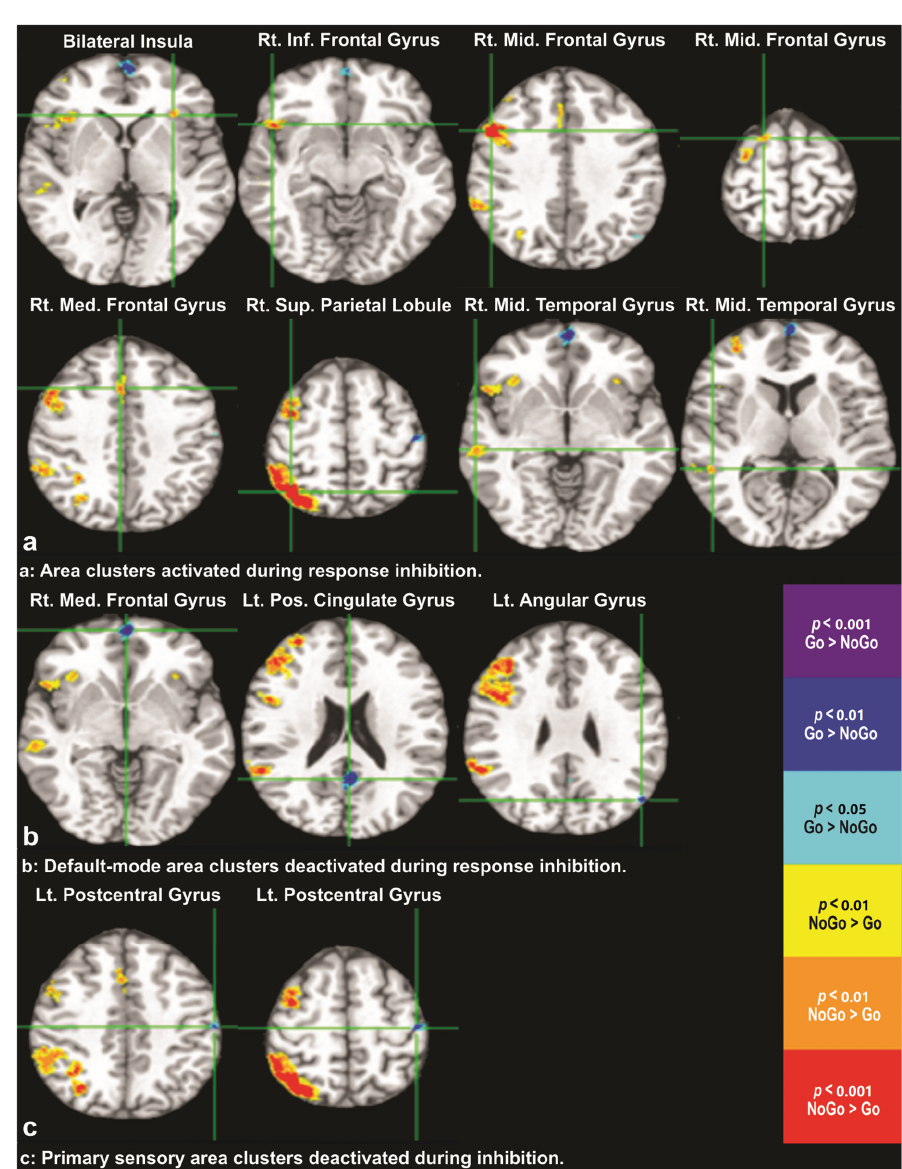
Figure 2. Thirteen voxel clusters where ( a ) 7 regions in the right hemisphere and bilateral anterior insula were activated, ( b ) 3 regions in the default-mode network were deactivated, and ( c ) 2 regions in the primary sensory areas were deactivated during successful response inhibition. All figures are in radiological